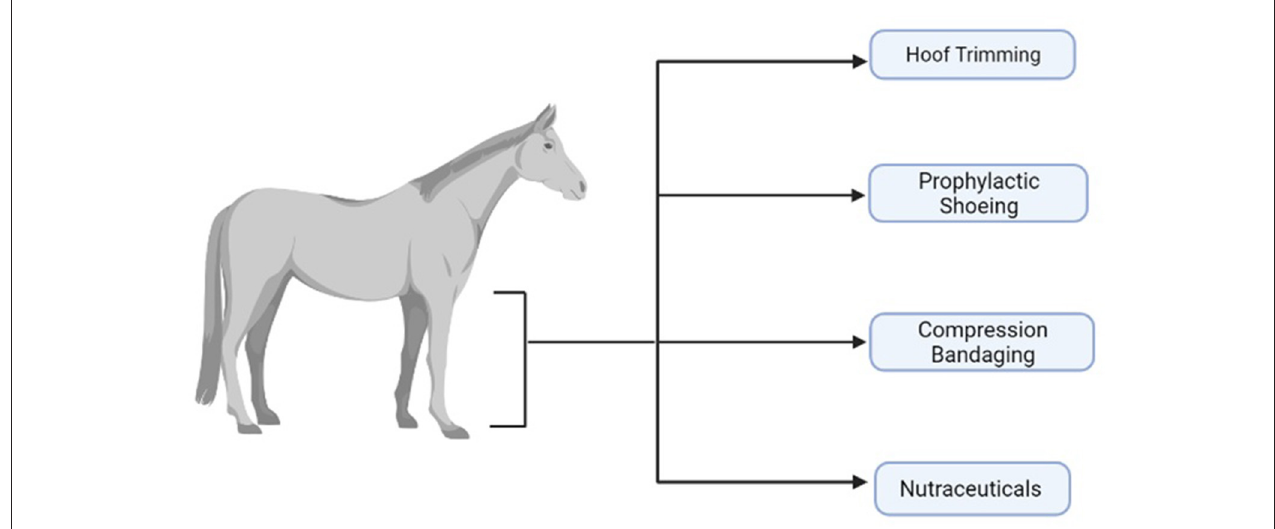
FIGURE 1 | A visual summary of some of the prevention modalities used in an attempt to maintain equine distal forelimb functionality. Created with